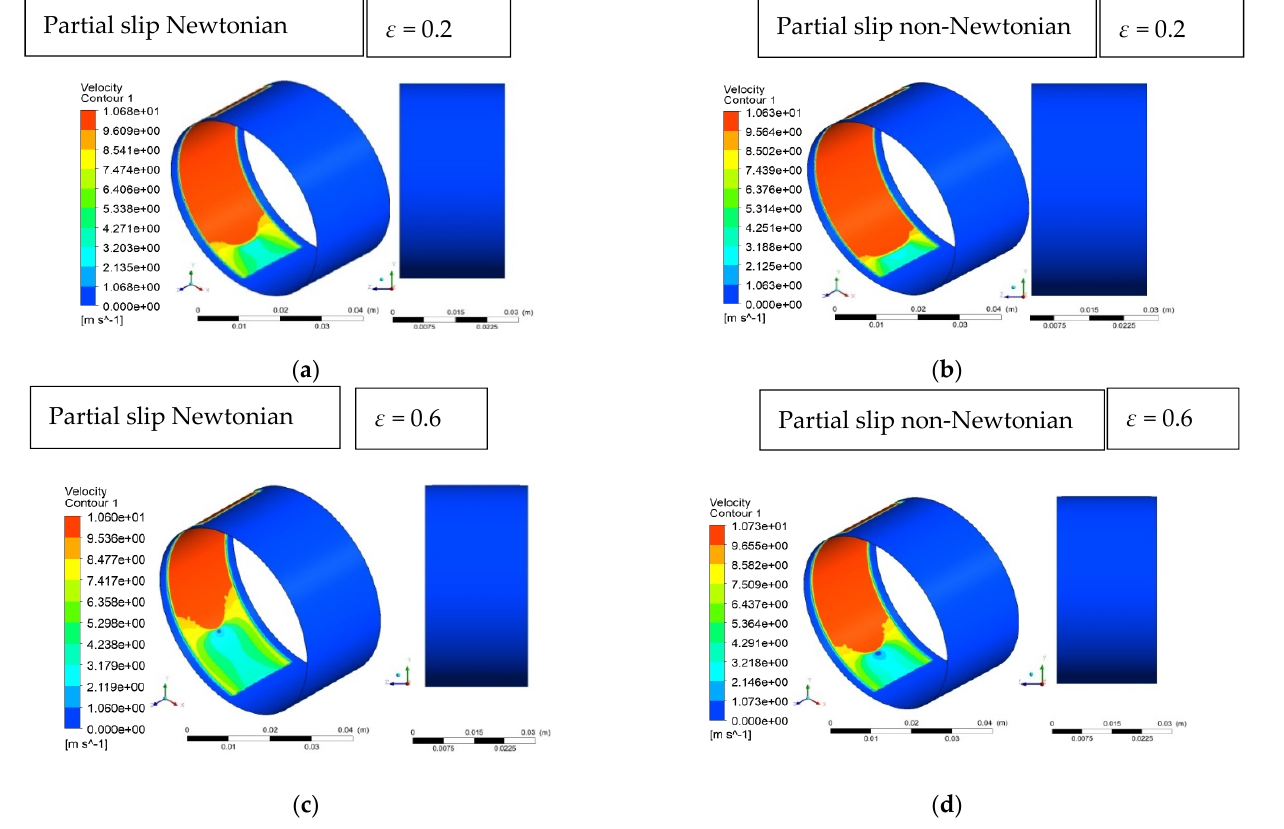
Figure 10. Velocity distribution for partial slip bearing for case: ( a ) Newtonian, ε = 0.2; ( b ) non- Newtonian, ε = 0.2; ( c ) Newtonian, ε = 0.6; ( d ) non-Newtonian, ε = 0.6.